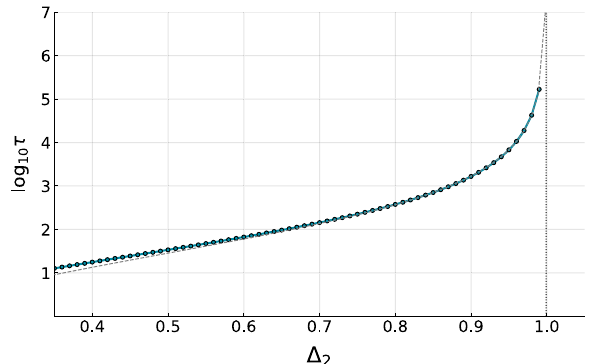
100 p ¼ ¯ C 0 ¼ 10 − 4